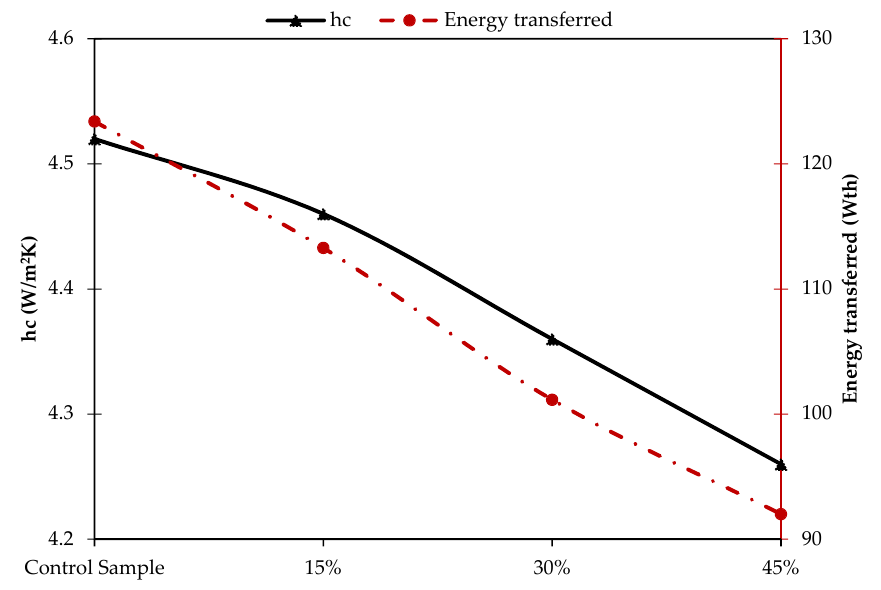
Figure 7. Convective heat transfer coefficient for indoor space on the primary axis and the amount of heat transferred from 1 m 2 surface area of the heated wall to the confined space on secondary axis.